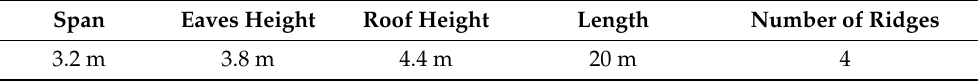
Table 2. Venlo greenhouse